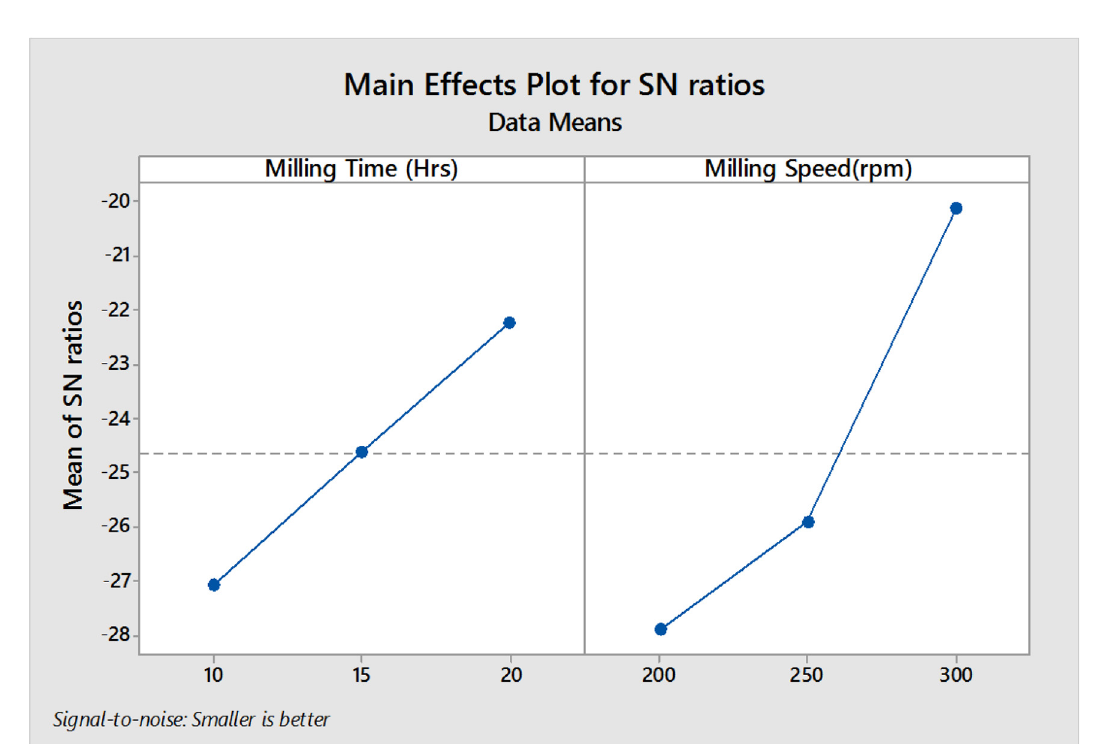
Fig. 2. Main effects plot for the signal to noise